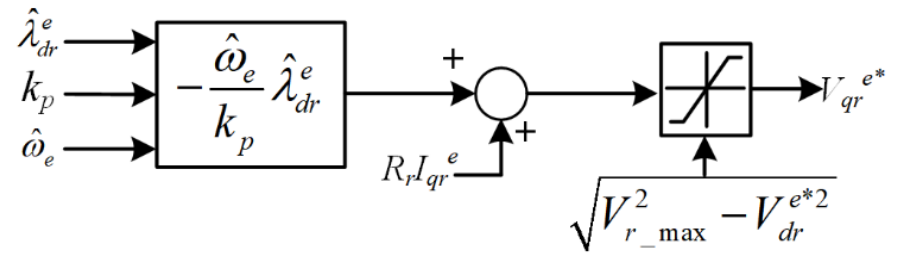
Figure 3. Block diagram of the power distribution control.